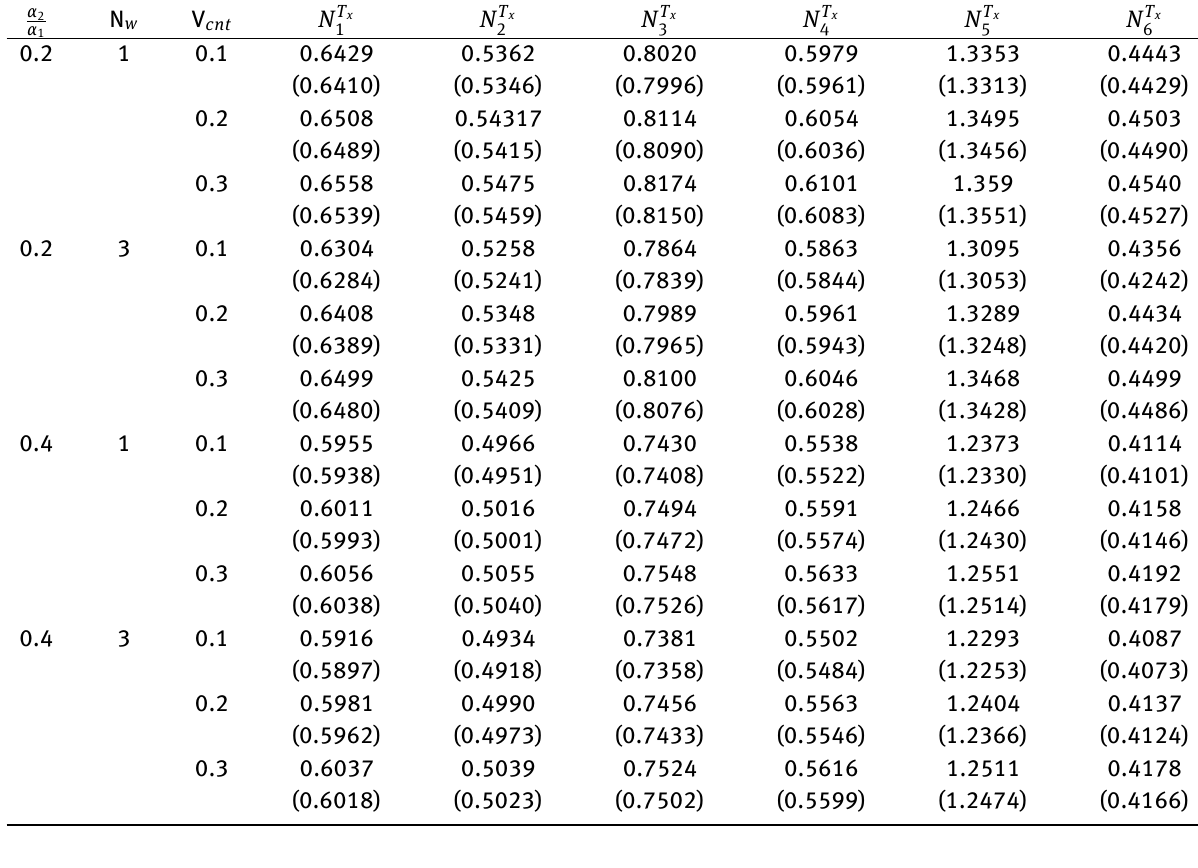
Table 9: Variation in CBT with inplane polynomial thermal forces with the CNT volume fraction and CTE α 2 α 1